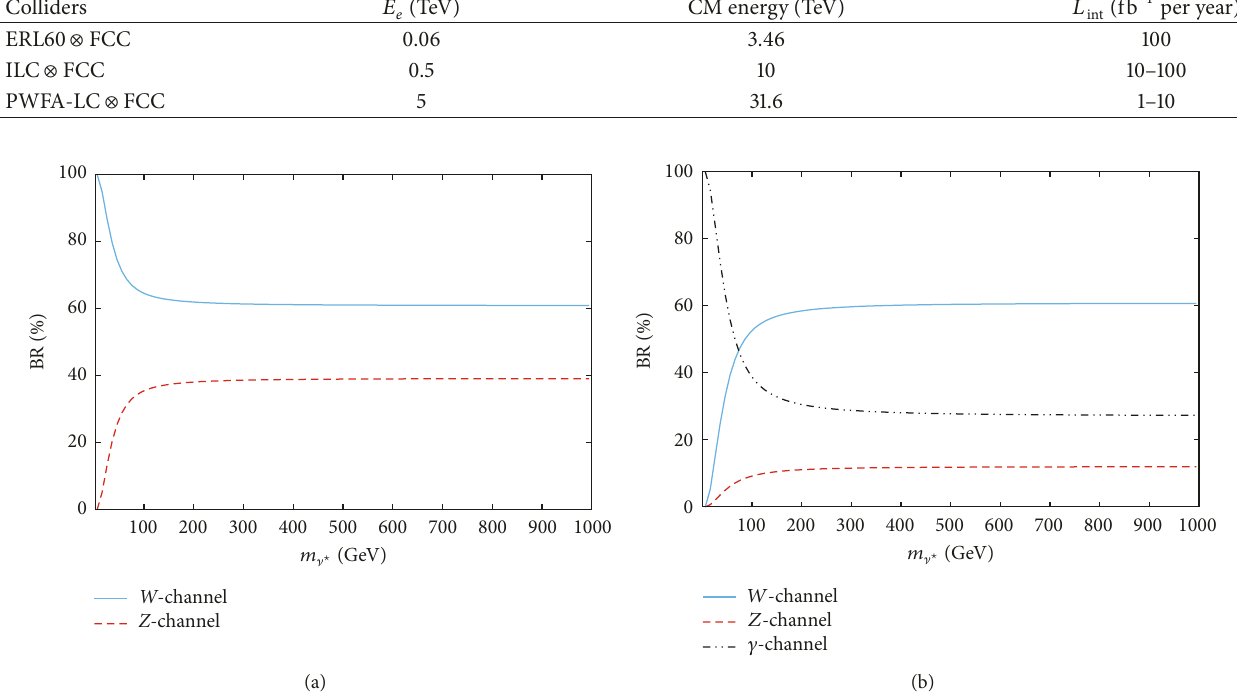
Figure 1: The branching ratios (%) depending on the mass of the excited neutrino for 𝑓 = 𝑓 󸀠 = 1 (a) and 𝑓 = −𝑓 󸀠 = 1 (b).